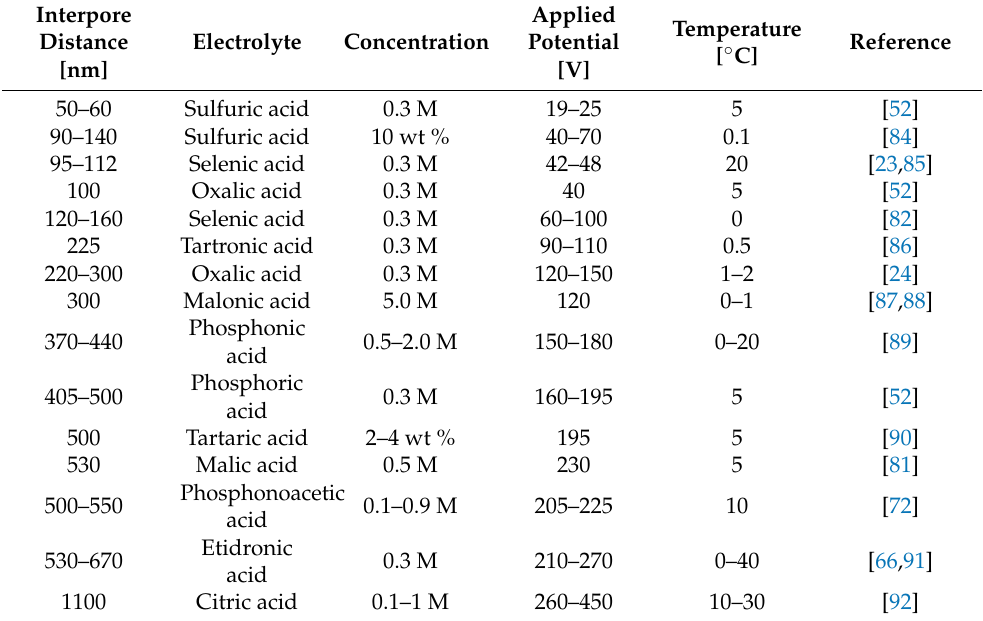
Table 1. Interpore distance reported for nanoporous anodic alumina anodized in various electrolytes.